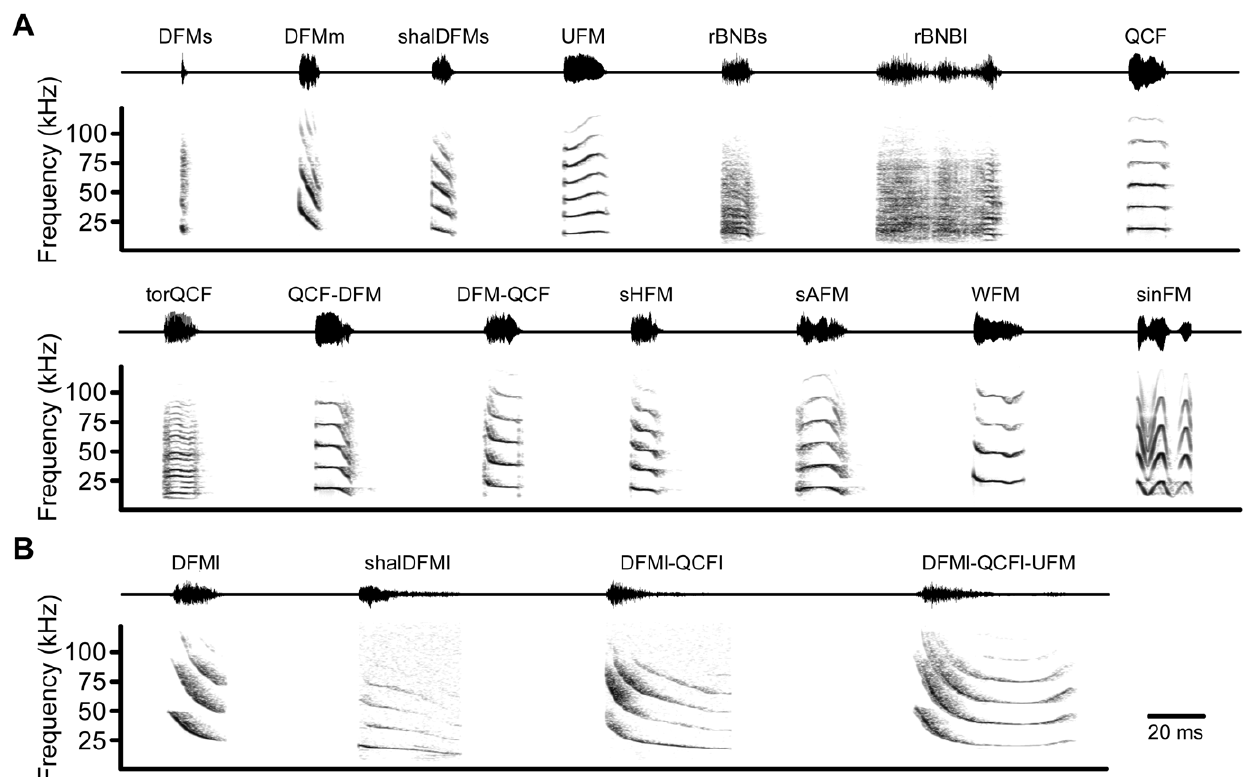
Figure 1. Syllable types of big brown bat social vocalizations. Example waveforms ( upper trace ) and spectrograms ( lower trace ) of 14 aggressive syllables ( A ), and 4 appeasement syllables ( B ). The time interval between syllables is for illustrative purposes and does not correspond to natural syllable emission rates. Peak amplitude of all syllables is normalized. Abbreviations : DFMs, downward frequency modulation, short; DFMm, downward frequency modulation, medium; shalDFMs, shallow downward frequency modulation, short; UFM, upward frequency modulation; rBNBs, rectangular broadband noise burst, short; rBNBl, rectangular broadband noise burst, long; QCF, quasi-constant frequency; torQCF, torus quasi- constant frequency; QCF-DFM, quasi-constant frequency to downward frequency modulation; DFM-QCF, downward frequency modulation to quasi- constant frequency; sHFM, single-humped frequency modulation; sAFM, single-arched frequency modulation; WFM, wrinkled frequency modulation; sinFM, sinusoidal frequency modulation; DFMl, downward frequency modulation, long; shalDFMl, shallow downward frequency modulation, long. DFMl-QCFl, downward frequency modulation long to quasi-constant frequency long; DFMl-QCFl-UFM, downward frequency modulation long to quasi-constant frequency long to upward frequency